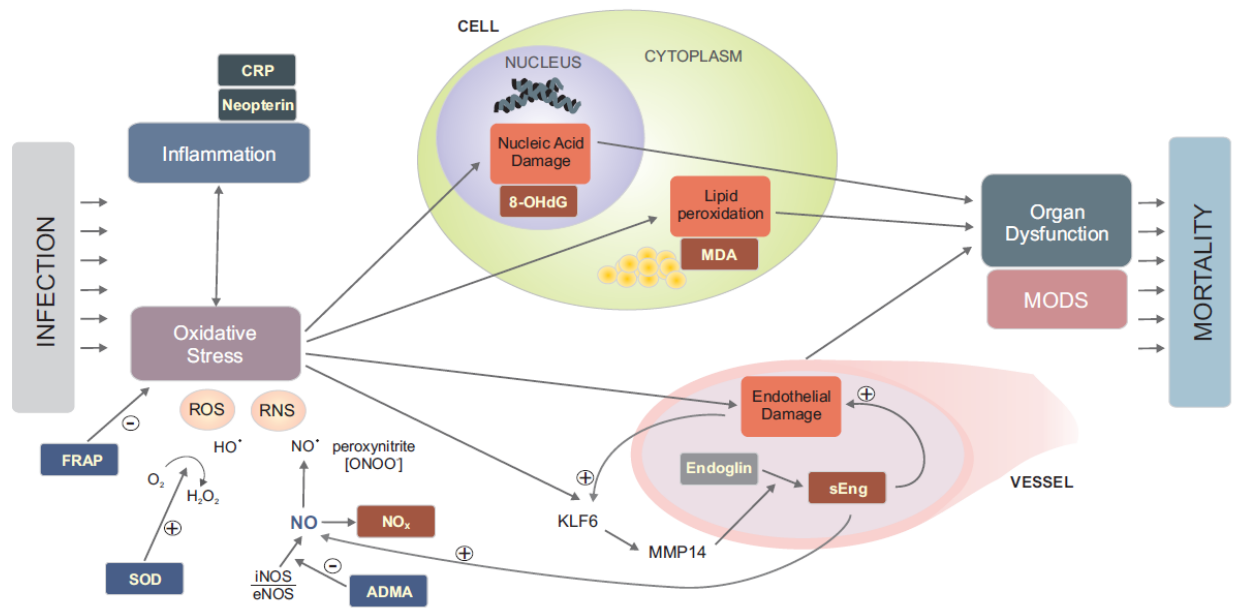
Figure 2. The diagram shows the presumed context of pathophysiological processes with sepsis. With sepsis, the host response to infection leads to deregulation of the inflammatory response. This is characterised by elevated CRP and neopterin levels. At the same time, oxidative stress is deregulated by increased ROS and RNS production. An indicator of excessive NO production is an increased NOx level. Opposite antioxidation mechanisms are also activated: SOD catalyses the conversion of the superoxide radical to the less toxic and reactive hydrogen peroxide and ADMA competitively suppresses NO synthesis. The level of plasma antioxidant capacity can be determined as FRAP. Oxidative stress leads to cell damage by lipid peroxidation and nucleic acid damage. The level of these phenomena is described by MDA and 8-OHdG markers, respectively. Endothelial dysfunction also develops. Through the activation of the transcription factor KLF6 and subsequent MMP14 metalloproteinase, a massive release of soluble endoglin from the endothelium occurs. Its function in respect of sepsis has not yet been clearly identified. It is not clear whether it is only due to or causes endothelial dysfunction. Among other things, it increases the production of NO. Damage to membranes, nucleic acids and the endothelium, caused by oxidative stress, leads to tissue damage, subsequent organ dysfunction and the development of multiorgan failure. The level of organ dysfunction correlates to the mortality of patients who are in septic shock.